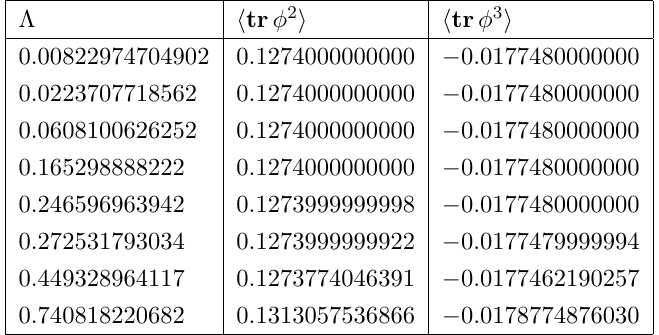
Table 2 . The values h tr (cid:30) 2 i , h tr (cid:30) 3 i obtained by inserting the values of a 1 , a 2 from table 1 into (5.6), (5.7) supplemented by q 4 and q 5 corrections. To be compared with (by